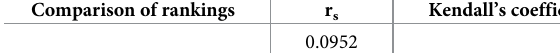
Attention to Housing Safety Documents. Degree of willingness to participate in the training of relevant knowledge of housing safety management. Attention to the surroundings of houses. Attention to the structure of residential buildings. Demand for housing problem solving. Degree of Demand for Legal Policies of Housing Safety Management. Degree of willingness to appraise houses at one’s own expense. Degree of willingness to buy commercial housing insurance. Degree of willingness to use houses safely. Degree of understanding of housing management law and policy. Kendall’s coefficient of concordance (W)